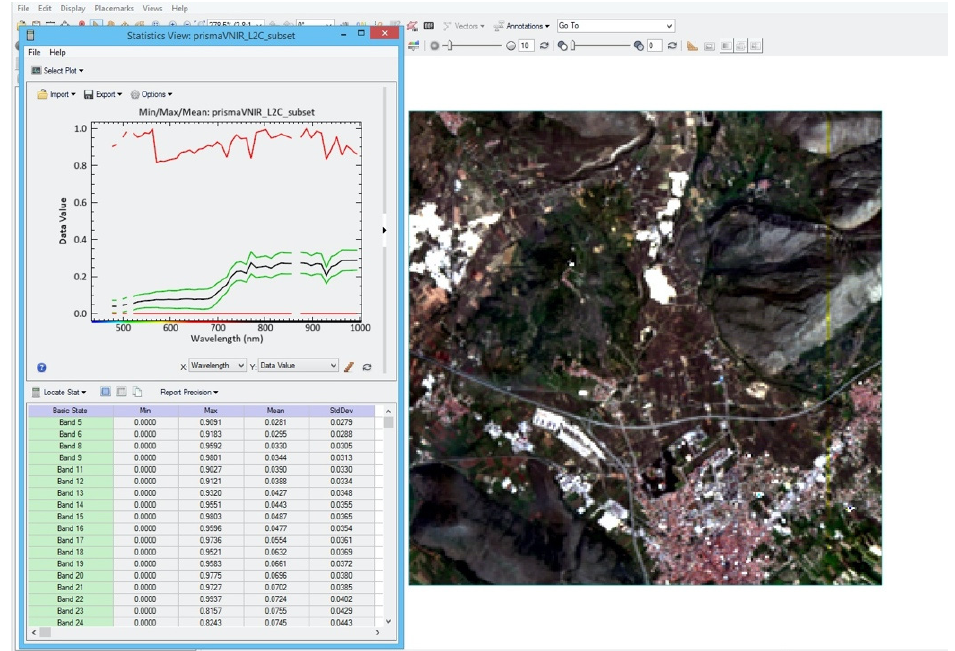
Figure 3. Display of bad bands in the Alba Fucens VNIR dataset: the trend of the statistical parameters (mean and standard deviation) with interruptions relating to bad bands can be observed.